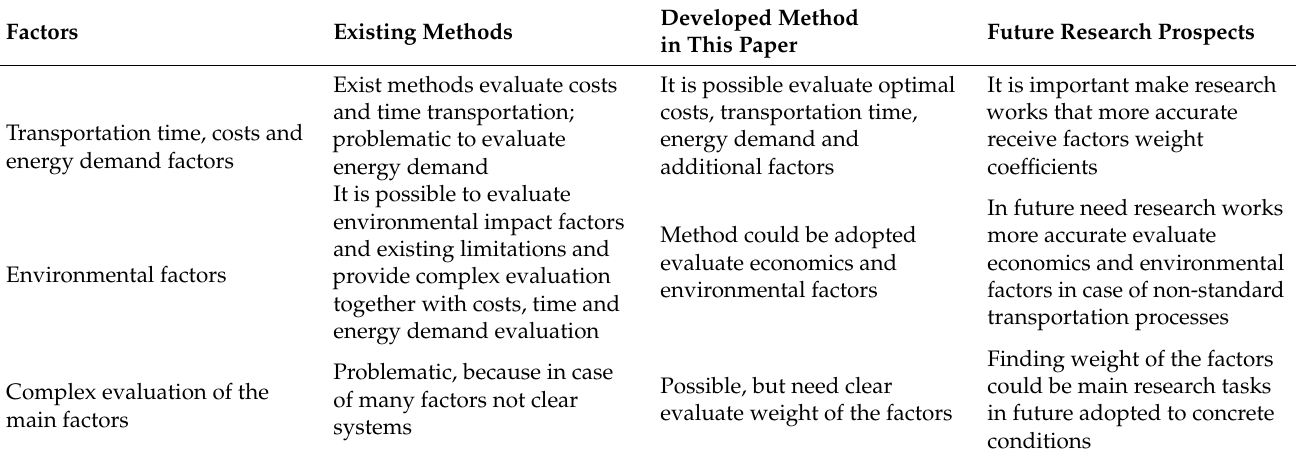
Table 4. Differences between existing transportation evaluation methods, developed method in this paper and future research